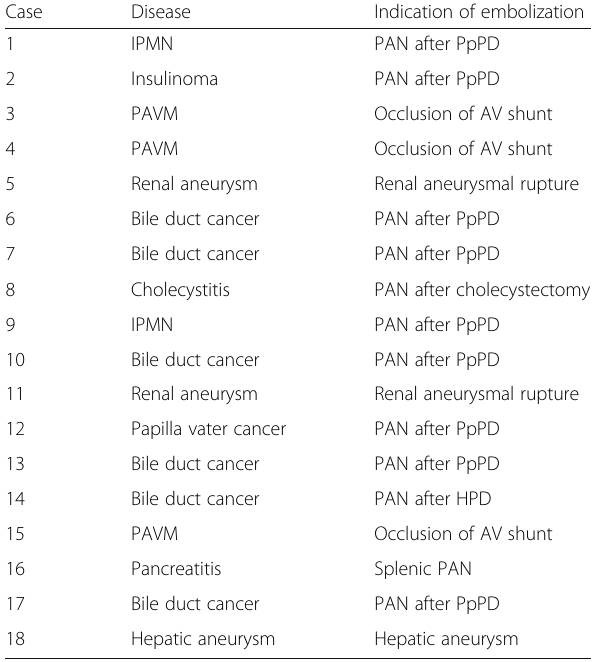
Table 1 Patient characteristics and medical history